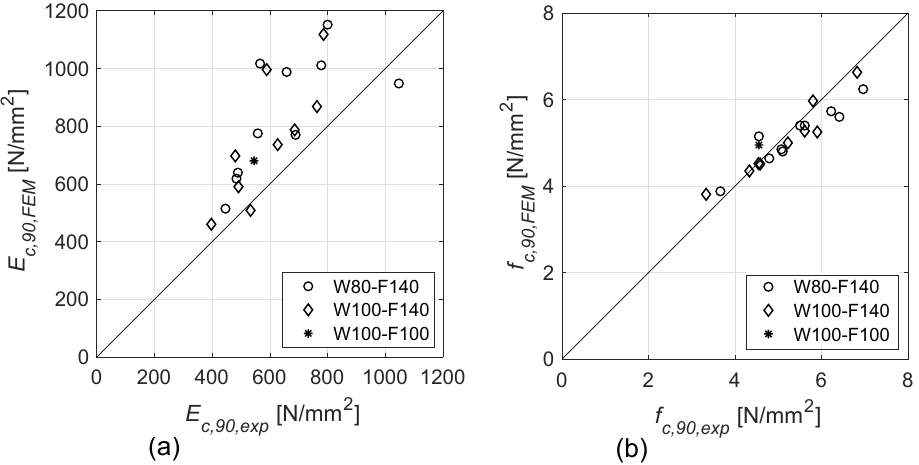
Figure 3. Correlation plot of ( a ) E c ,90 and ( b ) f c ,90 from FEM and experiment. The mean normalized absolute error of the model predictions of E c ,90 were 33.7% for series W80-F140 and 16.5% for series W100-F140 (see Figure 3a). In general, the